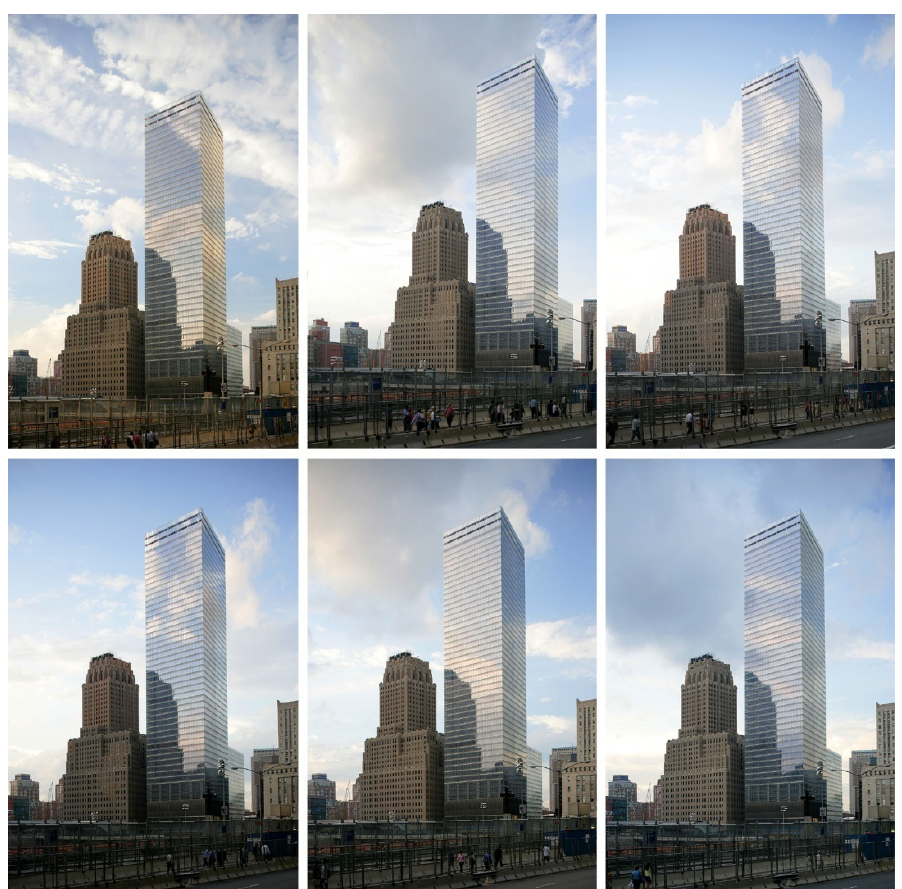
Figure 13: the 7 World Trade Center curtain wall responding to the sky